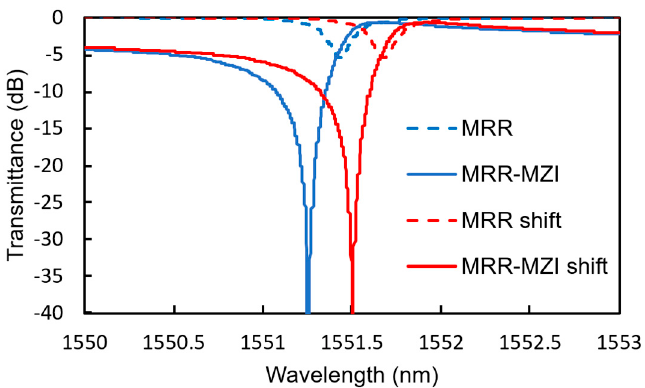
Figure 14. Dependence of the Q-factor and the phase shift enhancement factor Δ φ eff / Δ φ on K .